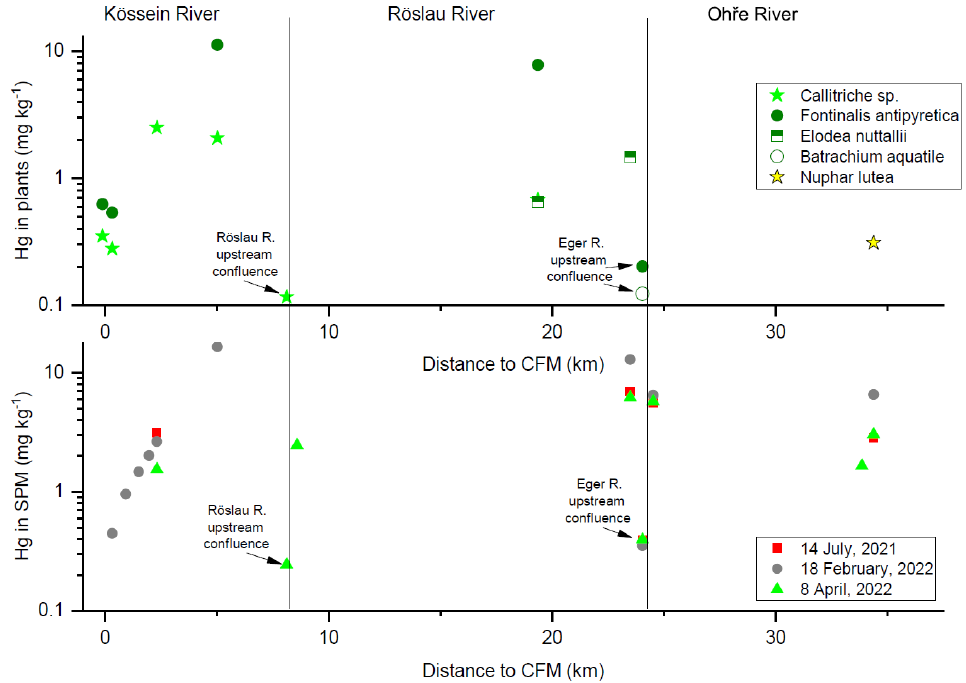
Figure 4. Longitudinal trends of Hg concentrations in aquatic plants (October 2021) and in SPM sampled during the three episodic events in summer 2021 and spring